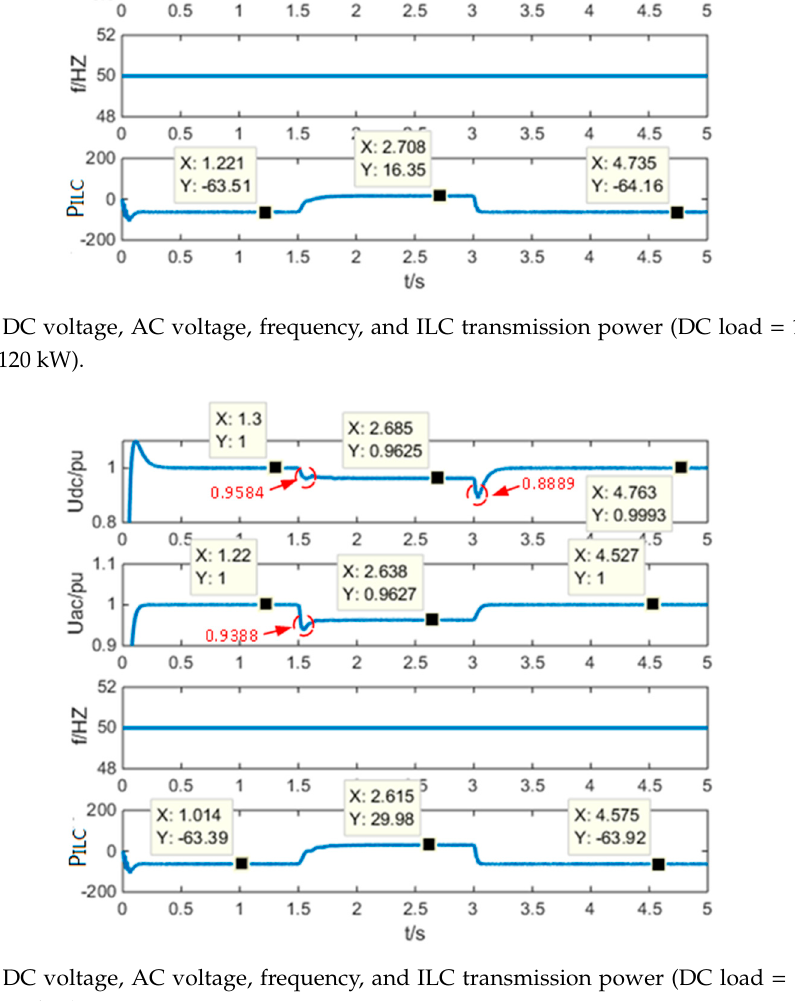
Figure 19. DC voltage, AC voltage, frequency, and ILC transmission power (DC load = 112.5 kW, AC load = 150 kW).